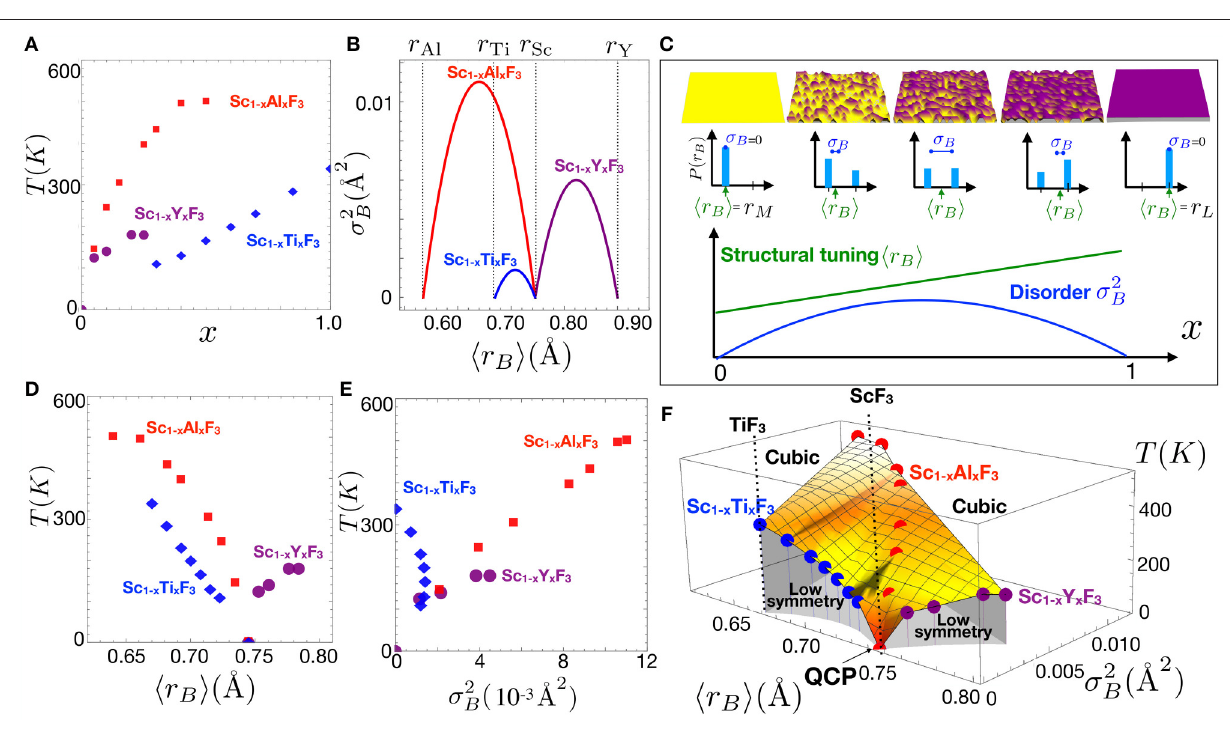
Frontiers in Chemistry |